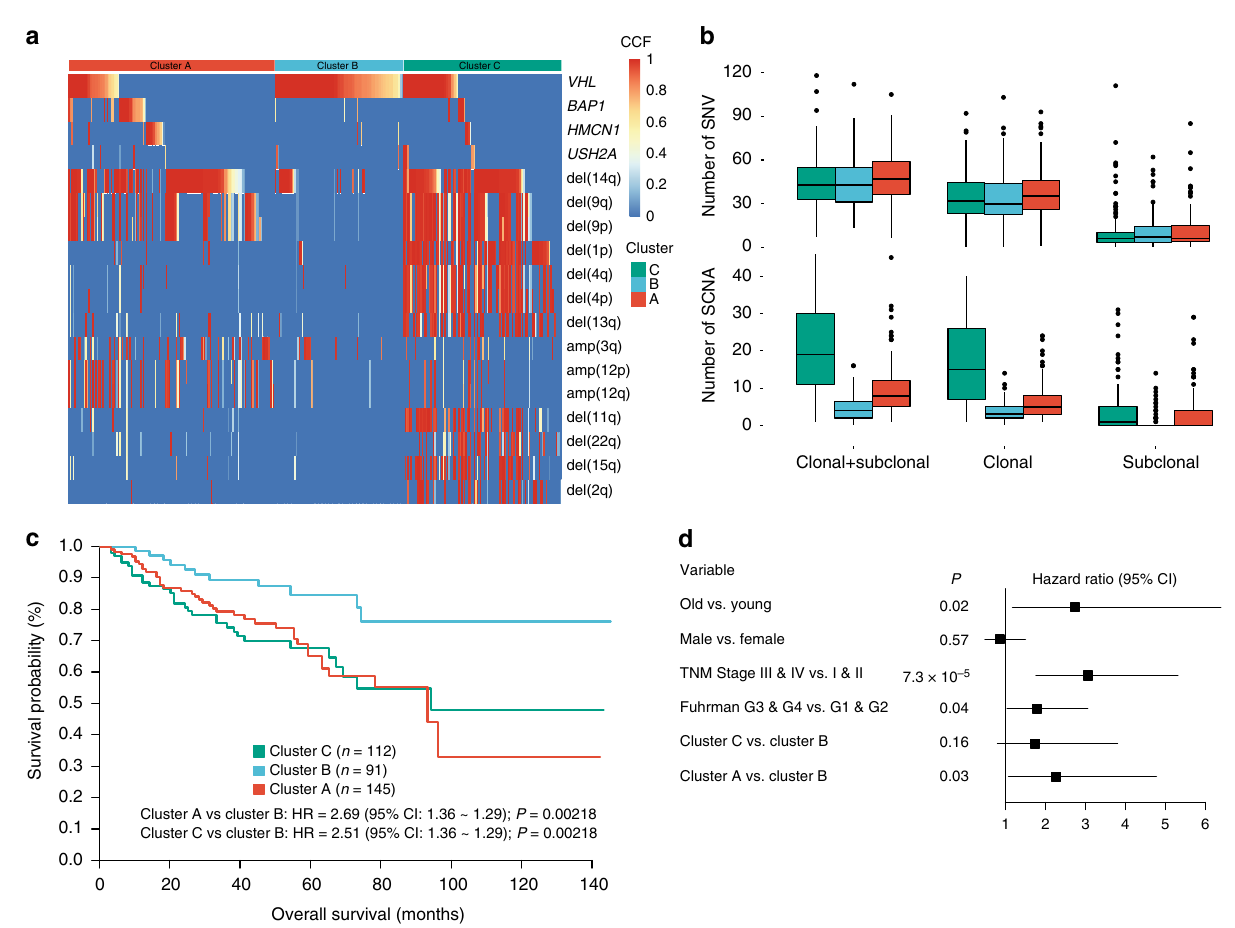
Fig. 4 Prognostic signi fi cance of molecular subtyping in ccRCC. a Molecular subtyping of ccRCC based on the CCF values of 18 frequent somatic events showing associations with clinical outcomes in univariate analyses. b Comparison of the overall burdens of SNVs and arm-level SCNAs among different genomic subtypes of ccRCC. The P values are determined by Student ’ s t tests. c Kaplan – Meier survival curves displaying survival outcomes of different clusters. d The results of multivariate Cox regression analyses adjusting for age, sex, TNM staging, Fuhrman grade, and molecular subtypes. Hazards ratio (HR), 95% con fi dence interval (CI), and P -values are